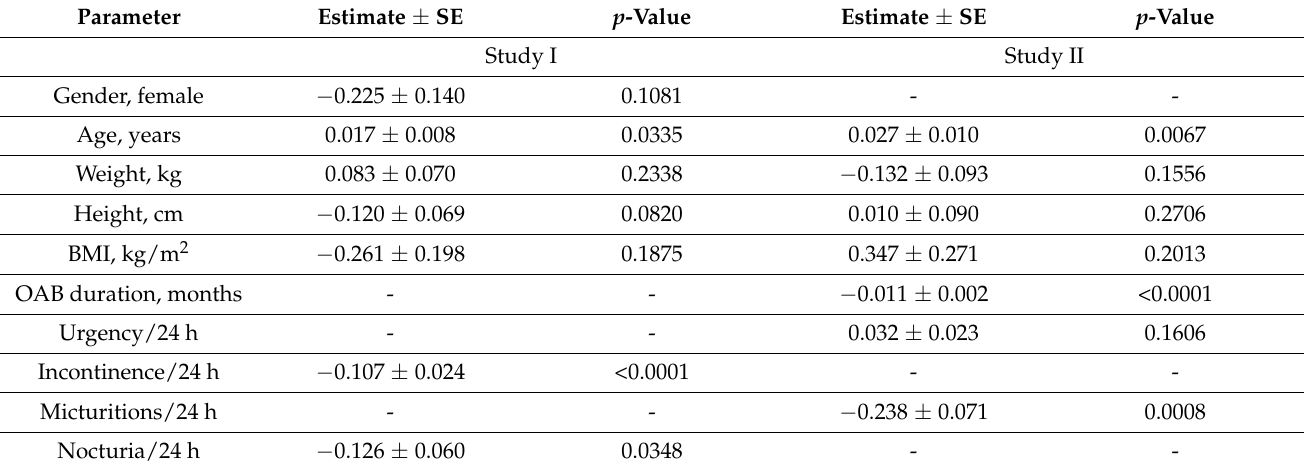
Table 2. Factors associated with starting dose (30 vs. 45 mg) in a logistic regression analysis of studies I and II. Data are the reported parameter for maximum likelihood estimate with its standard error (SE) and descriptive p -value based on Chi square tests. Parameters with a p > 0.3 were not retained in the model and are not